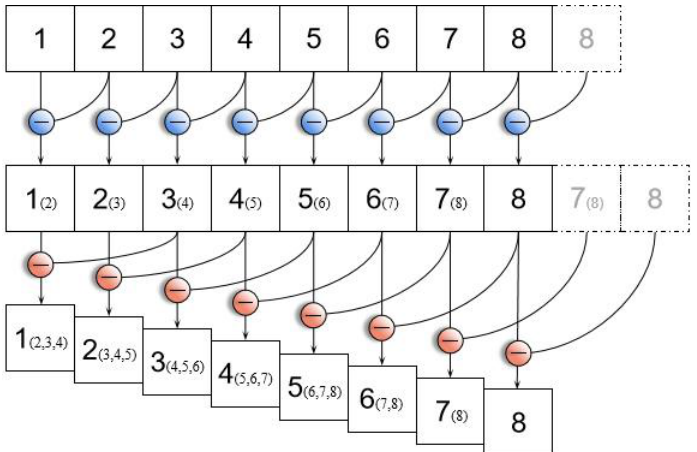
Figure 3. Graphic illustration of the HME module principle. The flow of arrows from the first row to the second row indicates the process of the ME module. Similarly, the flow of arrows from the second row to the third row represents the calculation process of the IFME module. The colors in the figure correspond to the colors in Figure 2. t ( l the feature-level motion information of the l 1 -th frame. Similar to t ( l